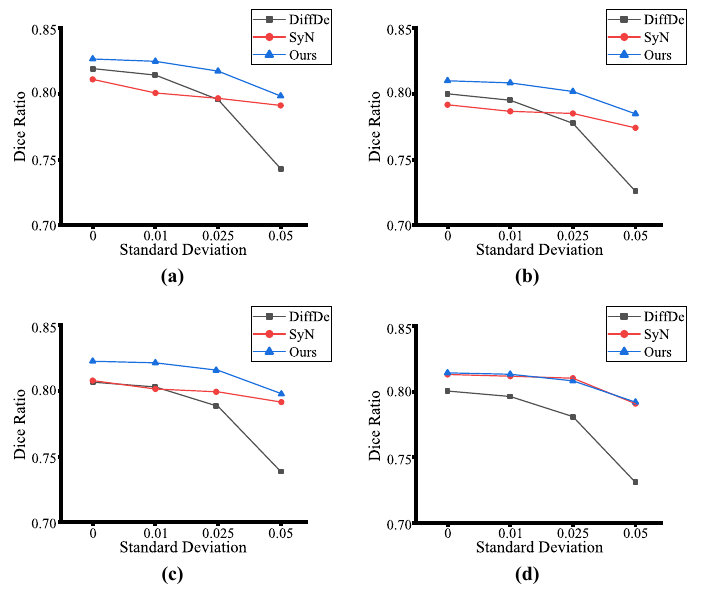
Figure 7. The quantitative results of Section 3.3 are shown. ( a ) The registration results from #227 to #161. ( b ) The registration results from #287 to #161. ( c ) The registration results from #319 to #161. ( d ) The registration results from #333 to #161. In each diagram, we plot the images of the Dice ratio with respect to the standard deviations of the noise, where 0 means no